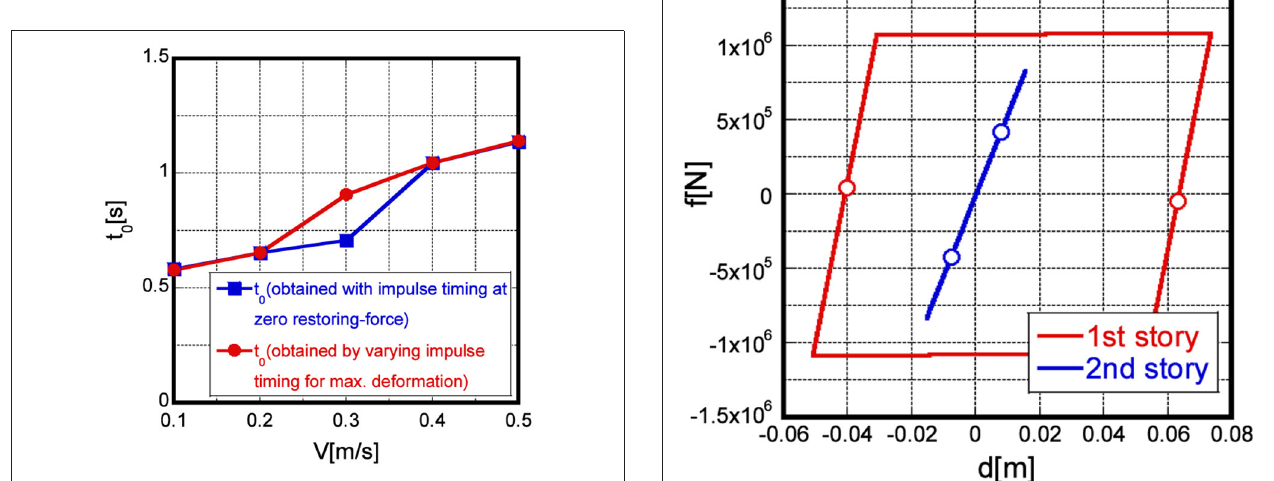
Frontiers in Built Environment |